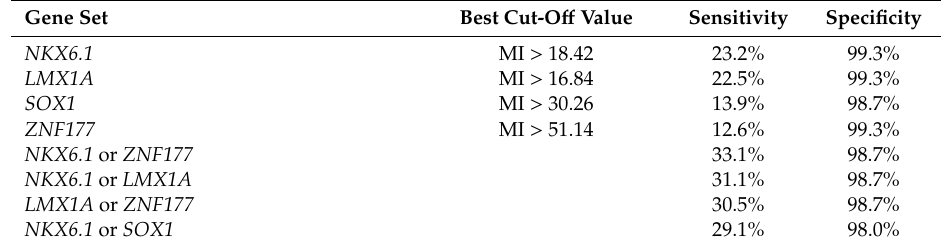
Table 1. Sensitivity and specificity of candidate gene sets for discriminating 151 CRC from nontumor tissues. Gene